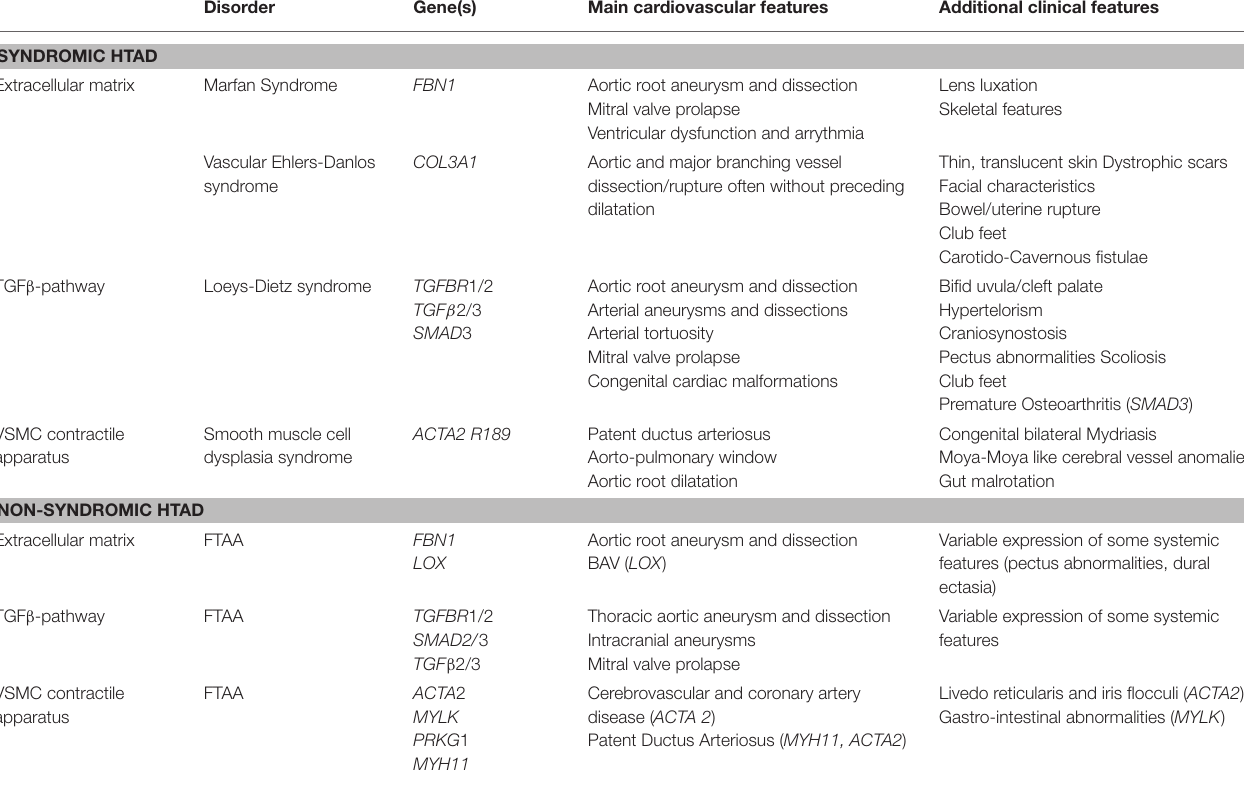
TABLE 1 | Main clinical features and genes * associated with Heritable Thoracic Aortic Aneurysm and